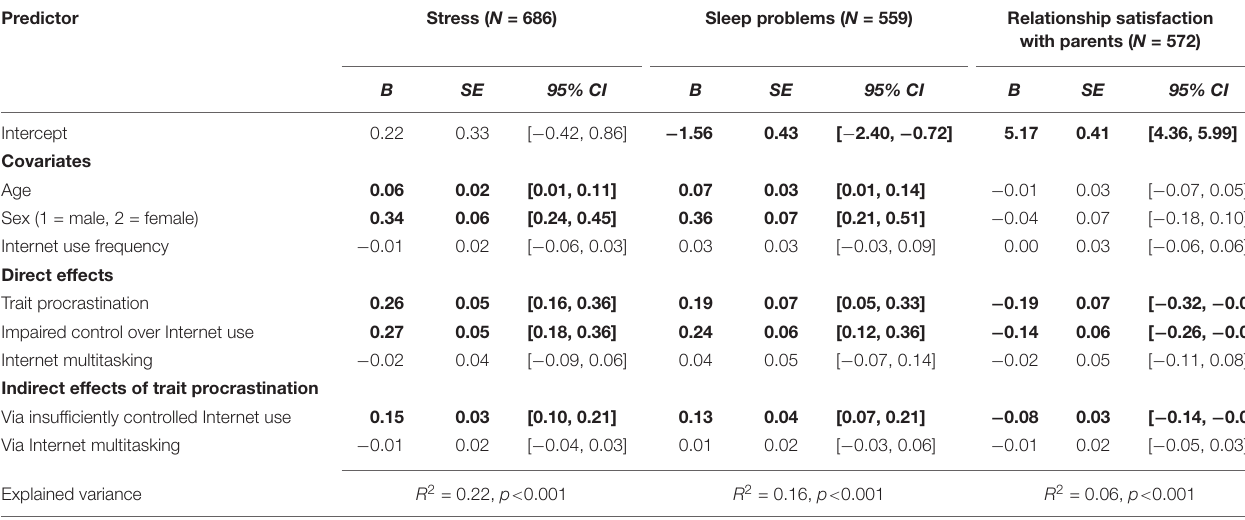
TABLE 3 | Parallel mediation analyses between trait procrastination ( X ), Internet multitasking ( M1 ), insufficiently controlled Internet use ( M2 ), and psychological functioning ( Y ).